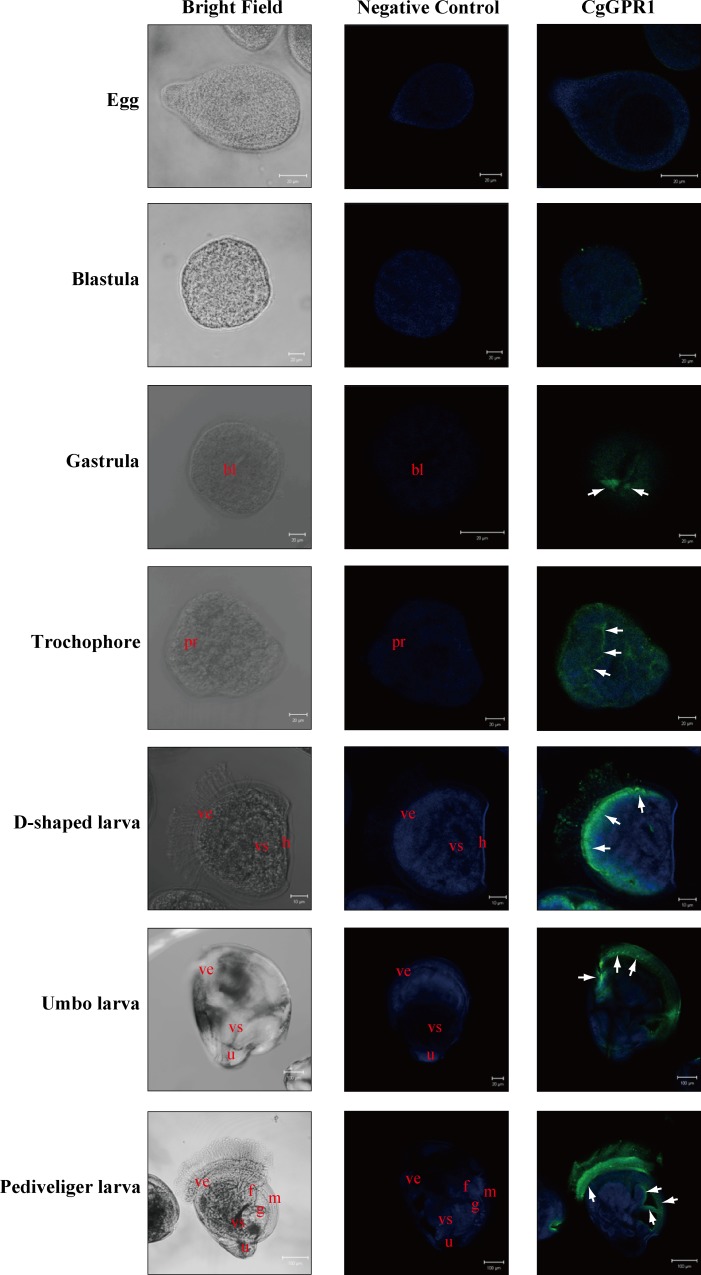
Whole-mount immunofluorescence of CgGPR1 in C. gigas larvae.The immunoreactive area was marked with arrow. bl, blastopore; pr, prototroch; ve, velum; vs, visceral mass; h, hinge; u, umbo; f, foot; g, gill; m, mantle.